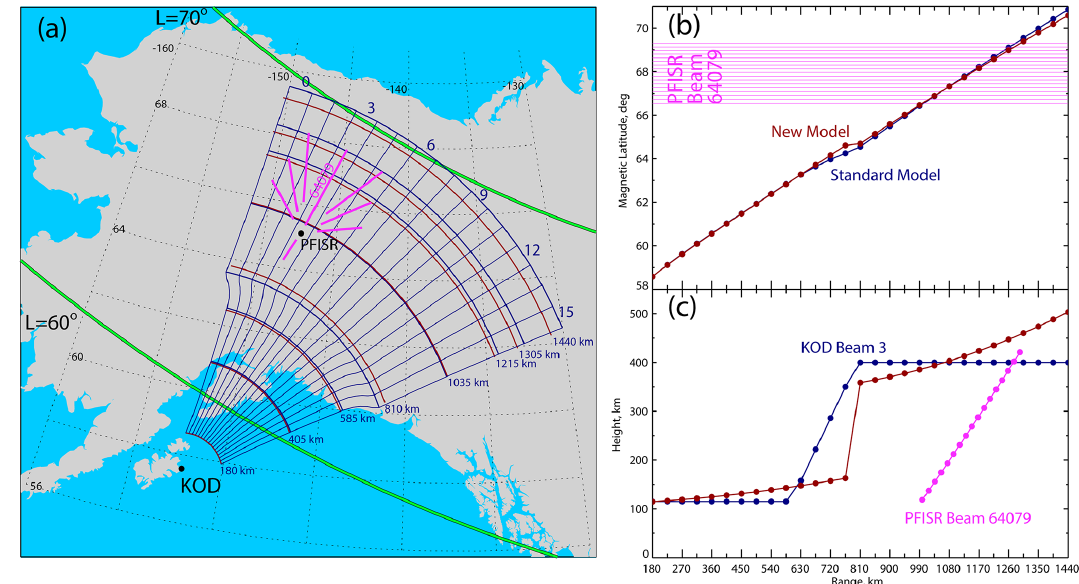
Figure 1. (a) Experiment setup diagram showing the near-range ( < 1440km) geographic footprint of the SuperDARN Kodiak radar (KOD) computed using the standard SuperDARN virtual height model (blue lines). The circular arcs show the start locations of selected range gates and straight lines show all 16 beams with beams 0, 3, 6, 9, 12, and 15 indicated by digits near range 1440km. The curved red lines are geographic locations of the same range gates computed using a new virtual height model by Chisham et al. (2008). Also shown are the beams of the Poker Flat Incoherent Scatter Radar (PFISR) corresponding to range gates with the long pulse data (thick pink lines) and lines of equal magnetic latitudes 3 = 60 ◦ N and 3 = 70 ◦ N computed using the altitude adjusted corrected geomagnetic (AACGM) model at an altitude 400km (green lines). The PFISR beam 64079 is indicated by the digits. The two panels on the right show the (b) AACGM magnetic latitude and (c) virtual height versus KOD range for the standard (blue) and new (red) virtual height models. The pink lines and dots represent range gates in PFISR beam